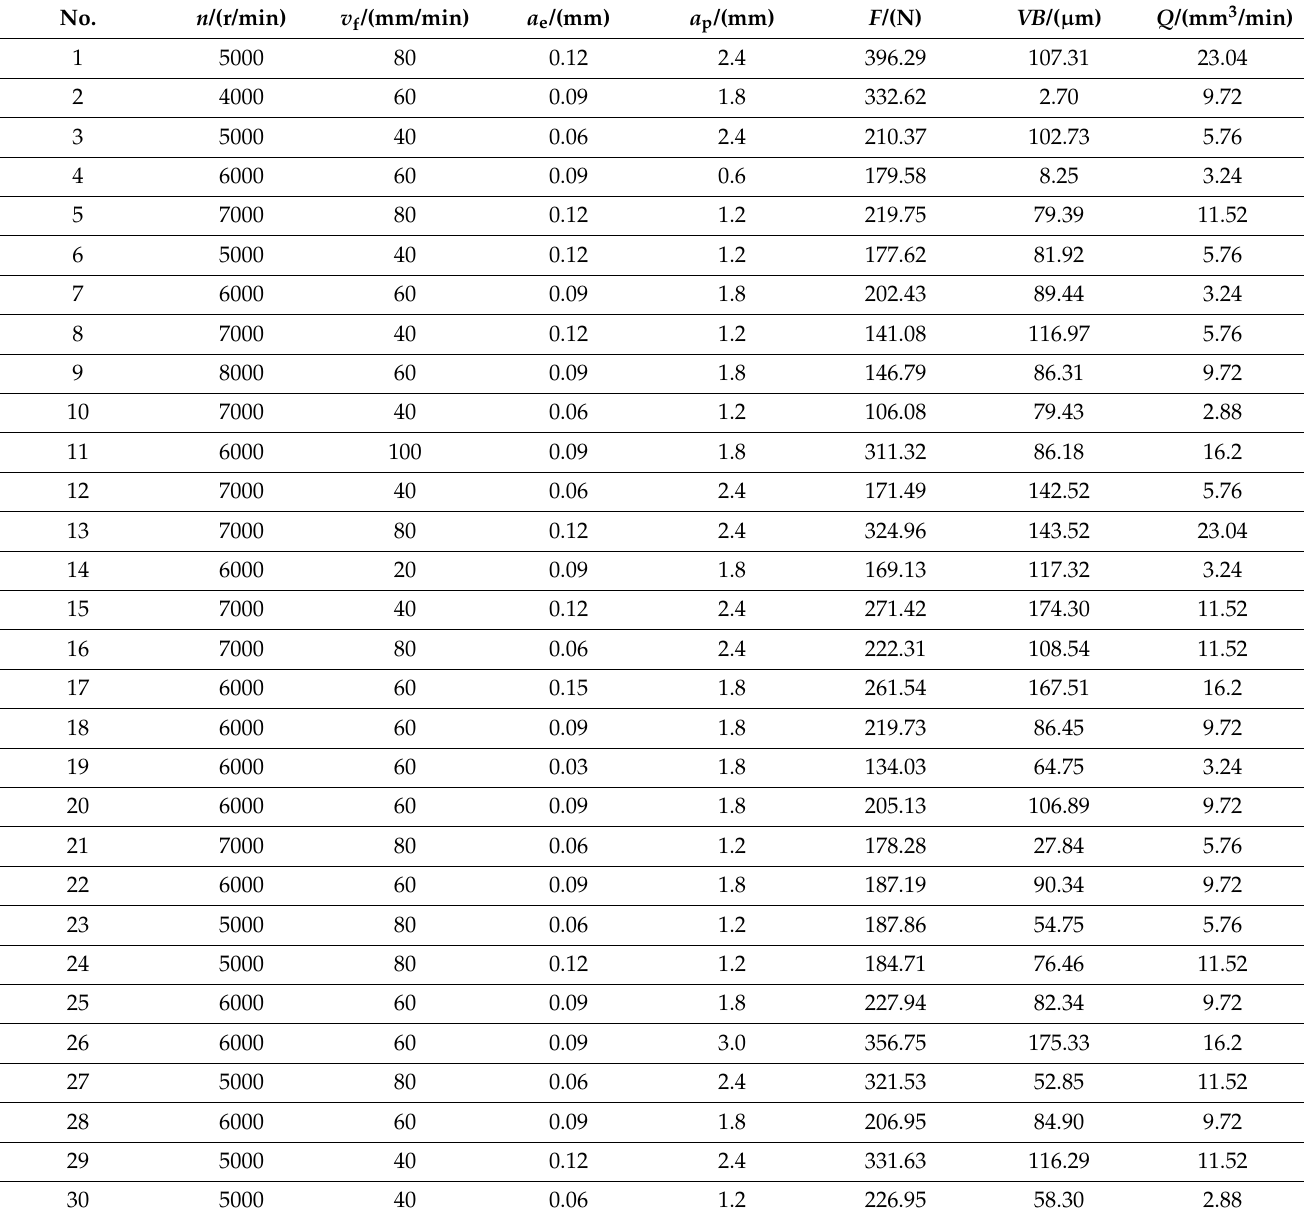
Table 4. Simulation results of zirconia ceramic